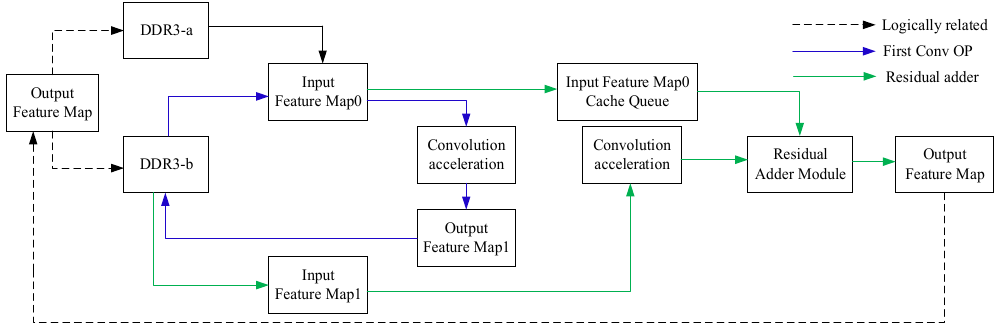
Figure 14. The schematic diagram of the residual calculation module.